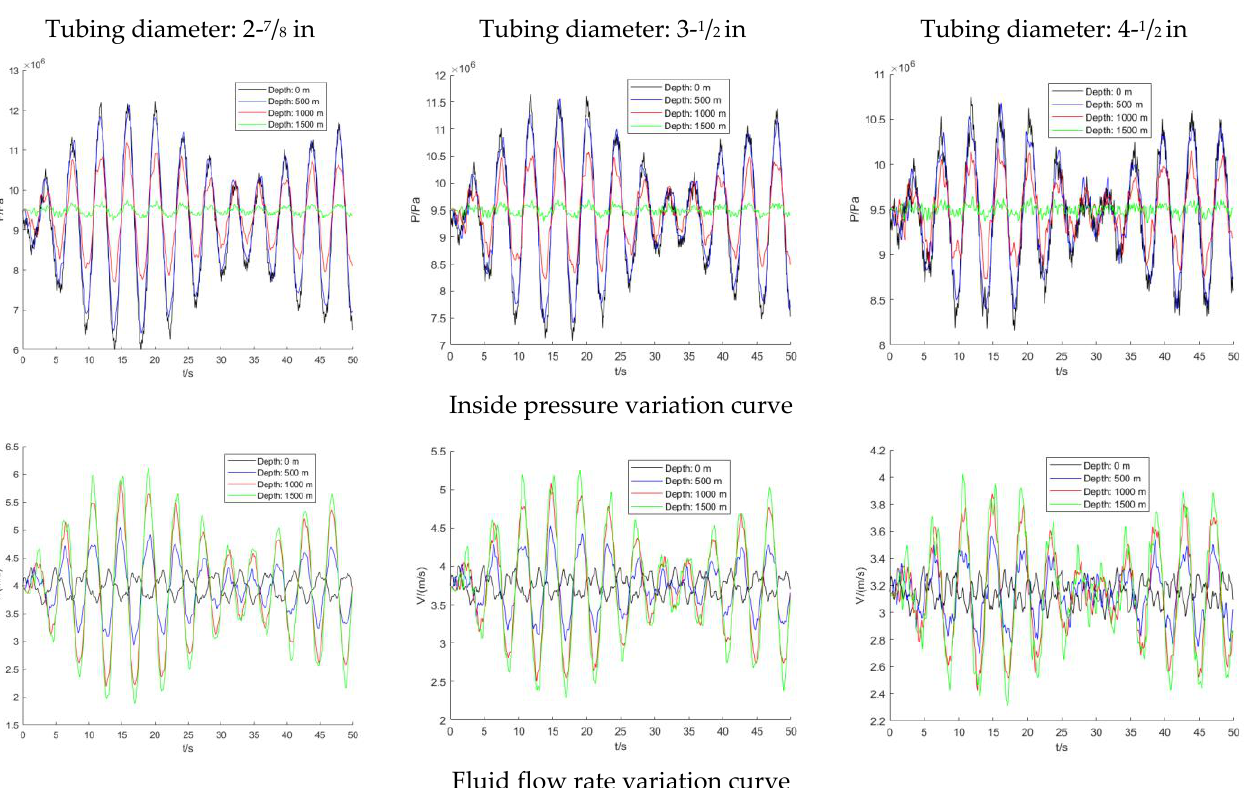
Figure 1. Variation curves of flow field parameters at different tubing